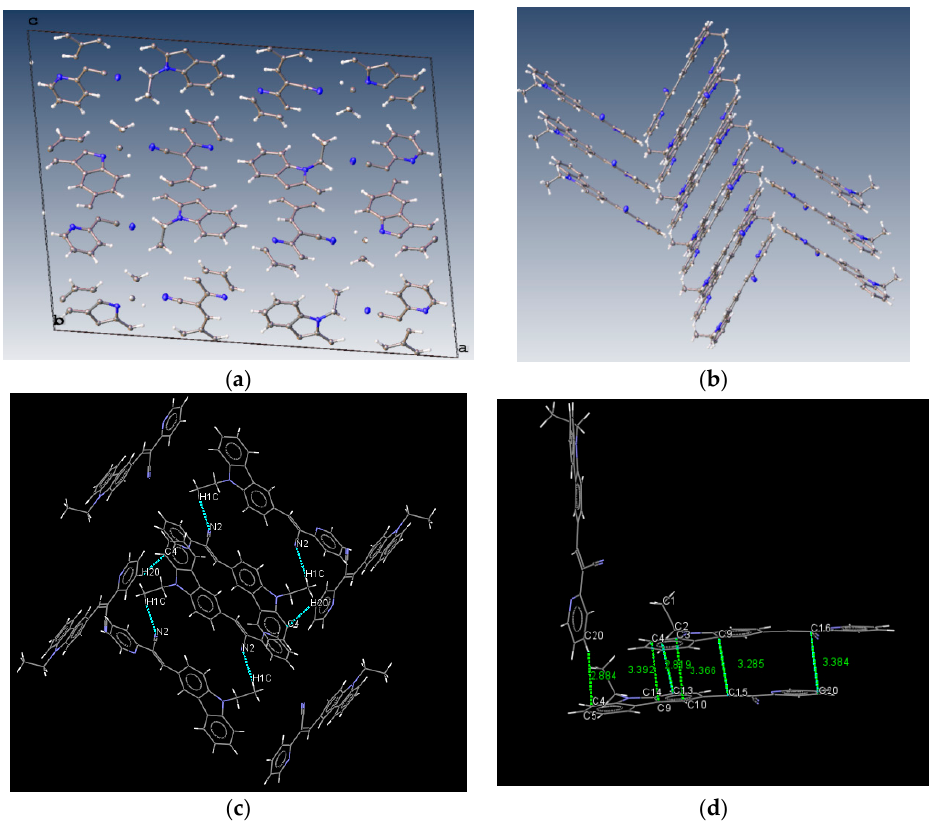
Figure 8. Molecule arrangement in the unit cell ( a ) and the herringbone packing motif ( b ) with the stacking of III , and a view showing the interactions, dashes lines ( c ) short contacts values along b axis ( d ).